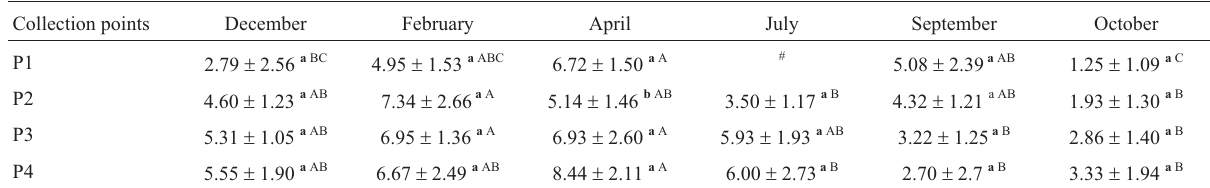
Table 3 - Mean mitotic index (MI) in Allium cepa meristematic cells exposed to P1, P2, P3 surface water samples collected from the Água Boa stream (Dourados, MS) and P4 (groundwater) during December 2012 and February, April, July, September, and October 2013. Collection